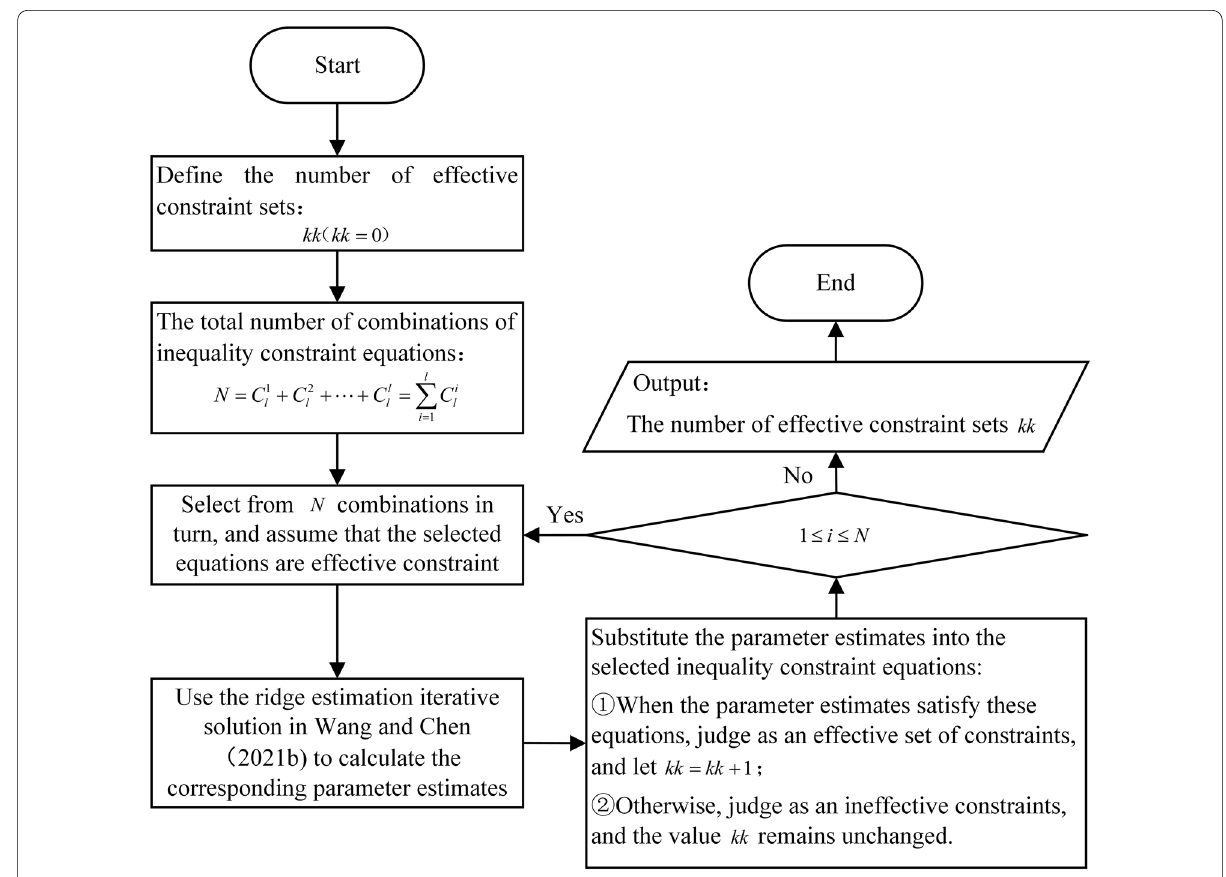
Fig. 3 Flowchart of utilizing the exhaustive search method to solve an ill-posed MAAMRE model with inequality constraints